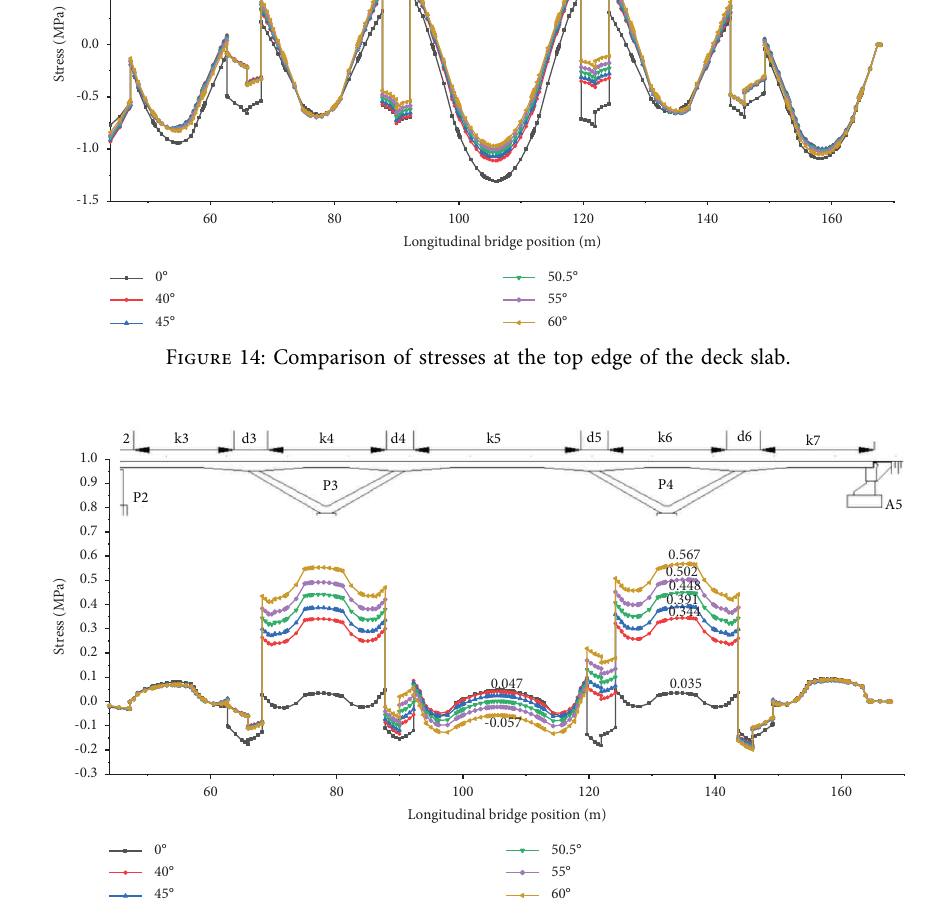
Figure 15: Comparison of stresses at the lower edge of the deck